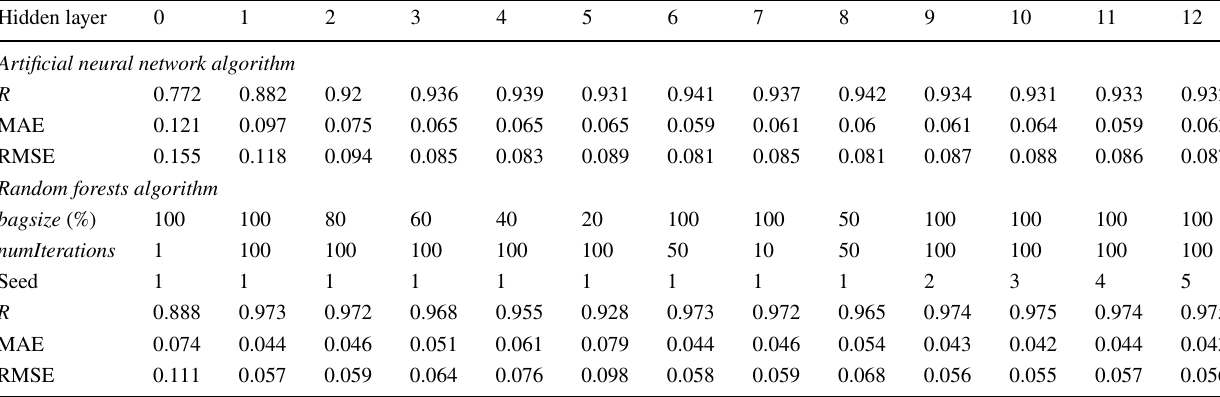
Table 1 Optimisation of parameters for ANN and RF algorithms Hidden layer Artificial neural network algorithm